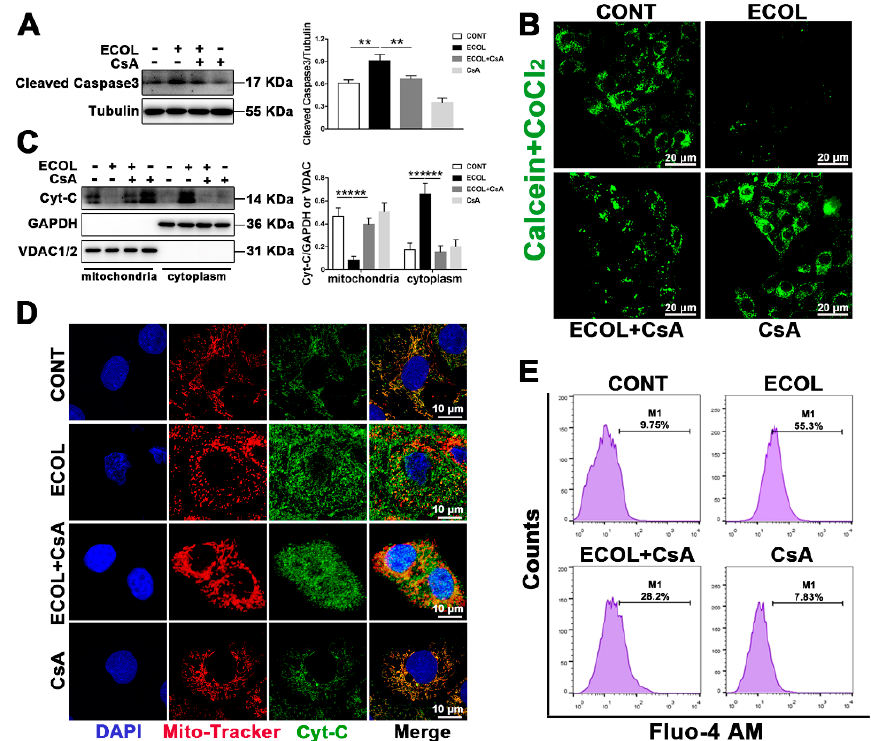
Figure 3. E. coli (EPEC) evokes the continuous opening of mPTP and mitochondrial Cyt-C and Ca 2+ release. ( A ) The cleaved caspase-3 level was analyzed by Western blot. ( B ) The opening of mPTP